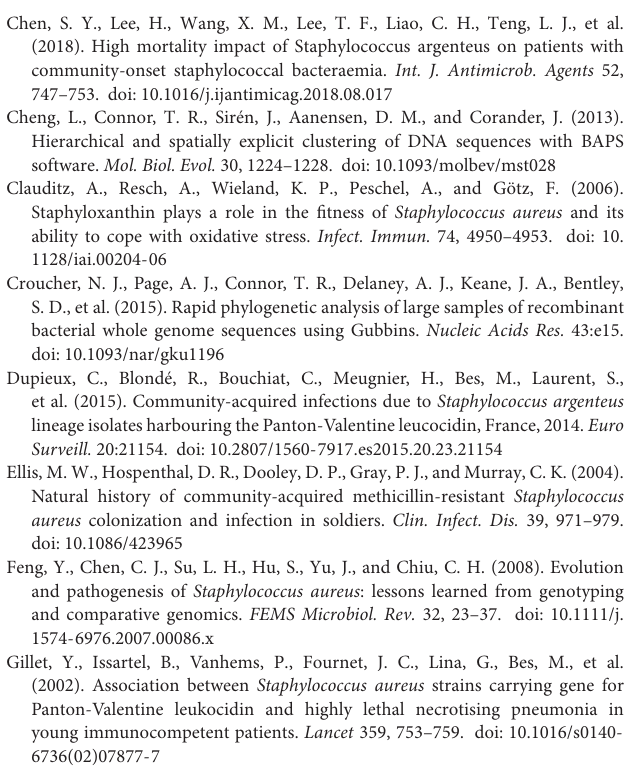
Supplementary Figure 1 | Bayesian analysis of the population structure of 153 S. argenteus strains. Each row in the figure represents a strain, each column represents an SNP, and horizontal black lines are drawn to separate the two clusters. The colour pattern of these SNPs within the black lines is consistent with their assignment to the same BAPS group. Supplementary Figure 2 | Hierarchical clustering in two dimensions of pairwise average nucleotide identity (ANI) comparisons of 153 S. argenteus strains. The